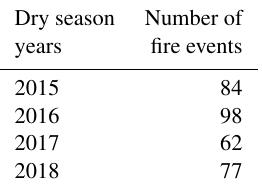
Table 4. Number of fire events occurring during the dry season (January–April) at Phimai from 2015–2018. Selection criteria of the data are the following: (1) situated within 100km of the site, (2) confidence level > 70%, and (3) daytime